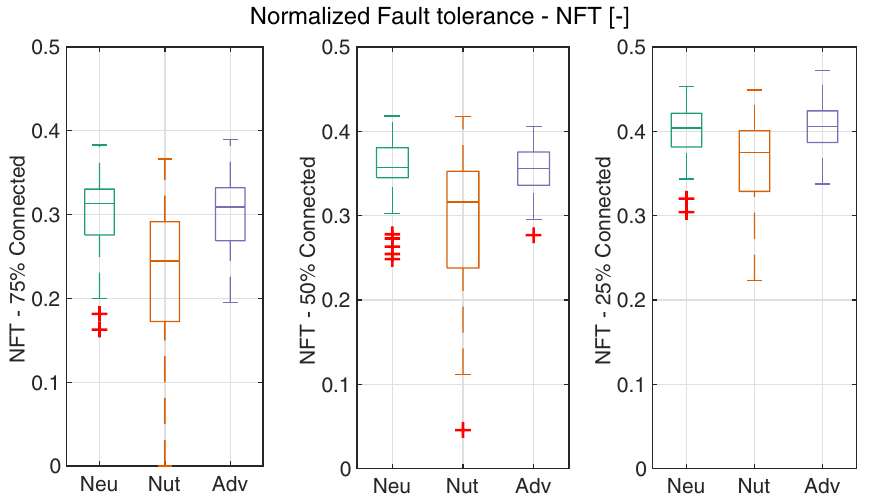
Figure 12. Normalized fault tolerances. The random fault tolerance (FT) is calculated as the percentage of edges that can be removed from a graph while still being able to connect 25% (left), 50% (middle) or 75% (right) of the graph edges. The FT is normalized to the interval [0, 1] where the lower and upper bounds correspond to the minimum spanning tree (MST) and Delaunay triangulation (DT), respectively. The edges to remove are chosen randomly and therefore the average of 30 replicates is reported for each graph and its bounds. Box plots show median (horizontal line), interquartile range (box), distance from upper and lower quartiles times 1.5 interquartile range (whiskers), and outliers ( > 1.5 x upper or lower quartile).